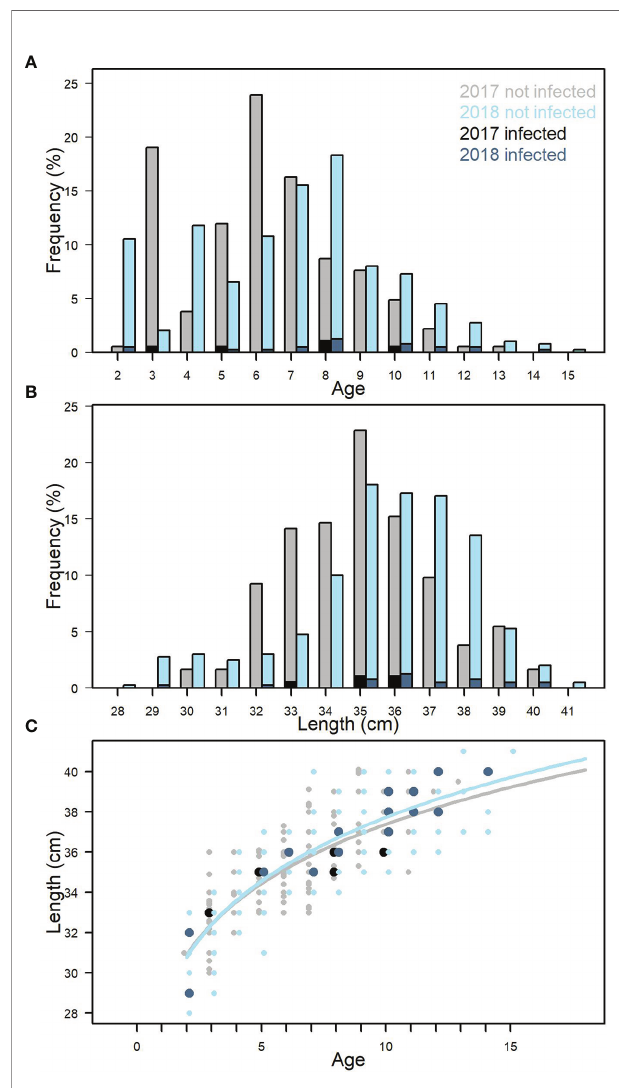
FIGURE 4 | Age distribution for all samples from 2017 and 2018 (A) . Length distribution for all samples from 2017 and 2018 (B) . Length-weight relationship for all samples. 2017 and 2018 (C) . Black and dark blue indicate fi sh infected with Kudoa thyrsites